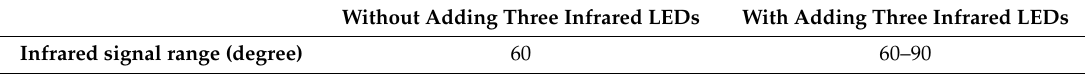
Figure 7. Infrared signal range with and without adding three infrared LEDs. Table 1. Infrared signal range with and without adding three infrared LEDs.